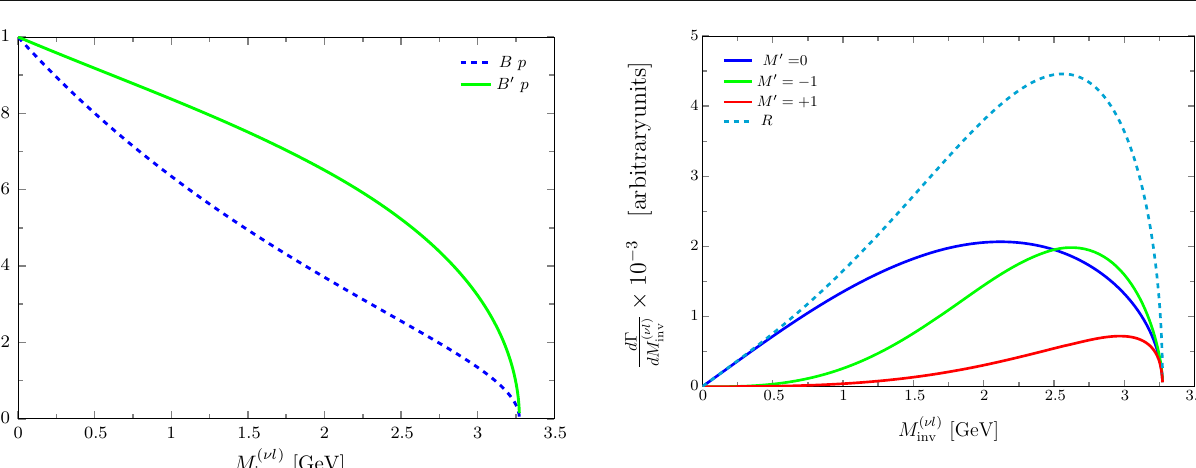
Fig. 3 Total differential width R , and individual contributions of d Γ